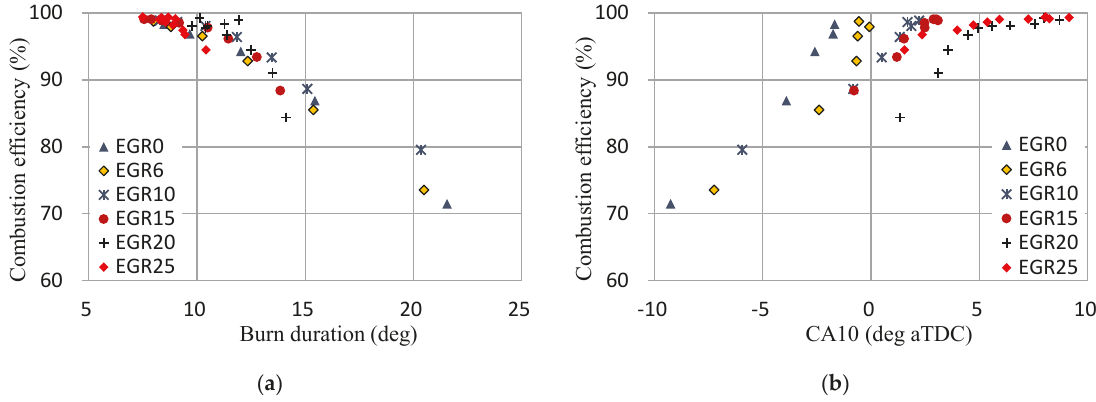
Figure 19. Combustion efficiency with respect to: ( a ) burn duration; ( b ) CA10.